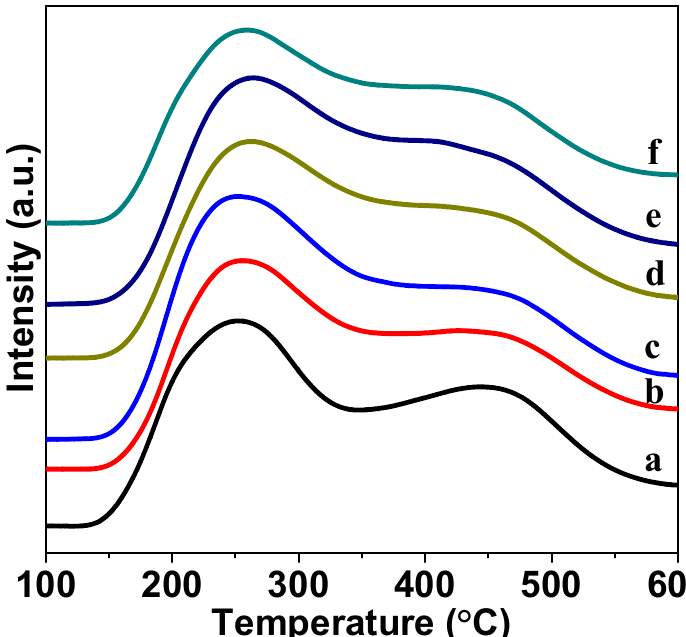
Figure 10. NH 3 -TPD profiles of ( a ) HMCM-49, ( b ) 2Mo(N)-HMCM-49, ( c ) 4Mo(N)-HMCM-49, ( d ) 6Mo(N)-HMCM-49, ( e ) 8Mo(N)-HMCM-49, and ( f ) 6Mo(C)-HMCM-49.